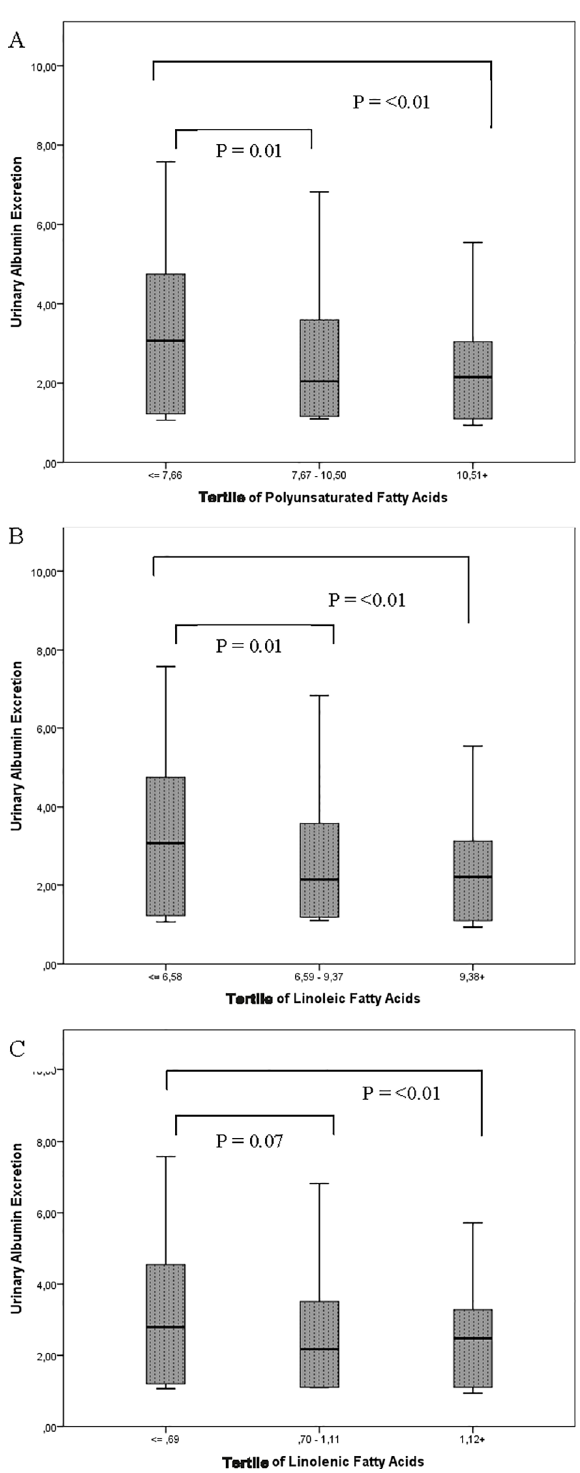
Fig 2. Albuminuria values in the tertiles of dietary fatty acids intake. 2A. Tertiles of dietary polyunsaturated fatty acids (% energy). 2B. Tertiles of dietary linoleic acid (% energy). 2C. Tertiles of dietary linolenic acid (% energy). Urinary Albumin Excretion is expressed